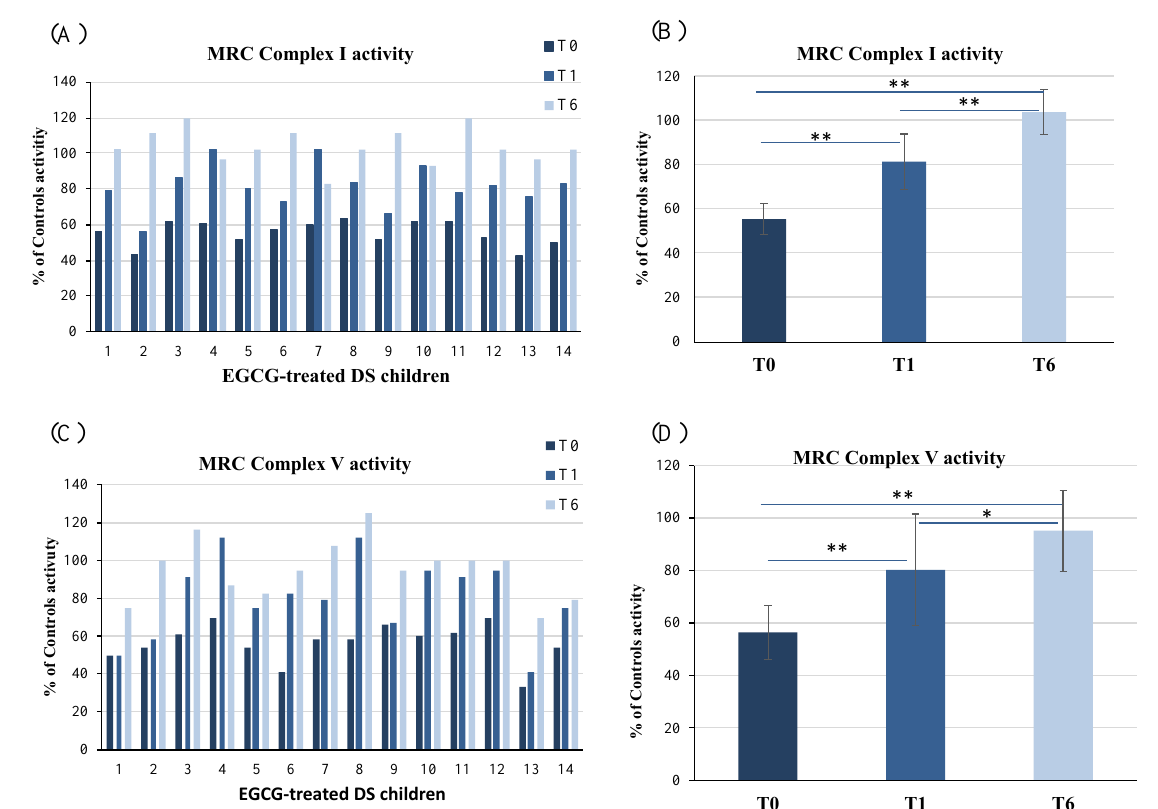
Figure 2. Mitochondrial respiratory chain complex I and complex V activities in PBMCs of DS children before (T0), after 1 (T1) and 6 (T6) months of nutraceutical supplementation with EGCG. Complex I and V activities are expressed as % of controls activity. Controls were 6 age-matched children without trisomy 21 (Group 3). Data reported in ( A , C ) are the mean value of two different measurements. MRC Complex I and V activities mean values of all EGCG-treated DS patients are reported in panels ( B , D ). Bars represent mean ± SD. * p < 0.05, ** p < 0.001.